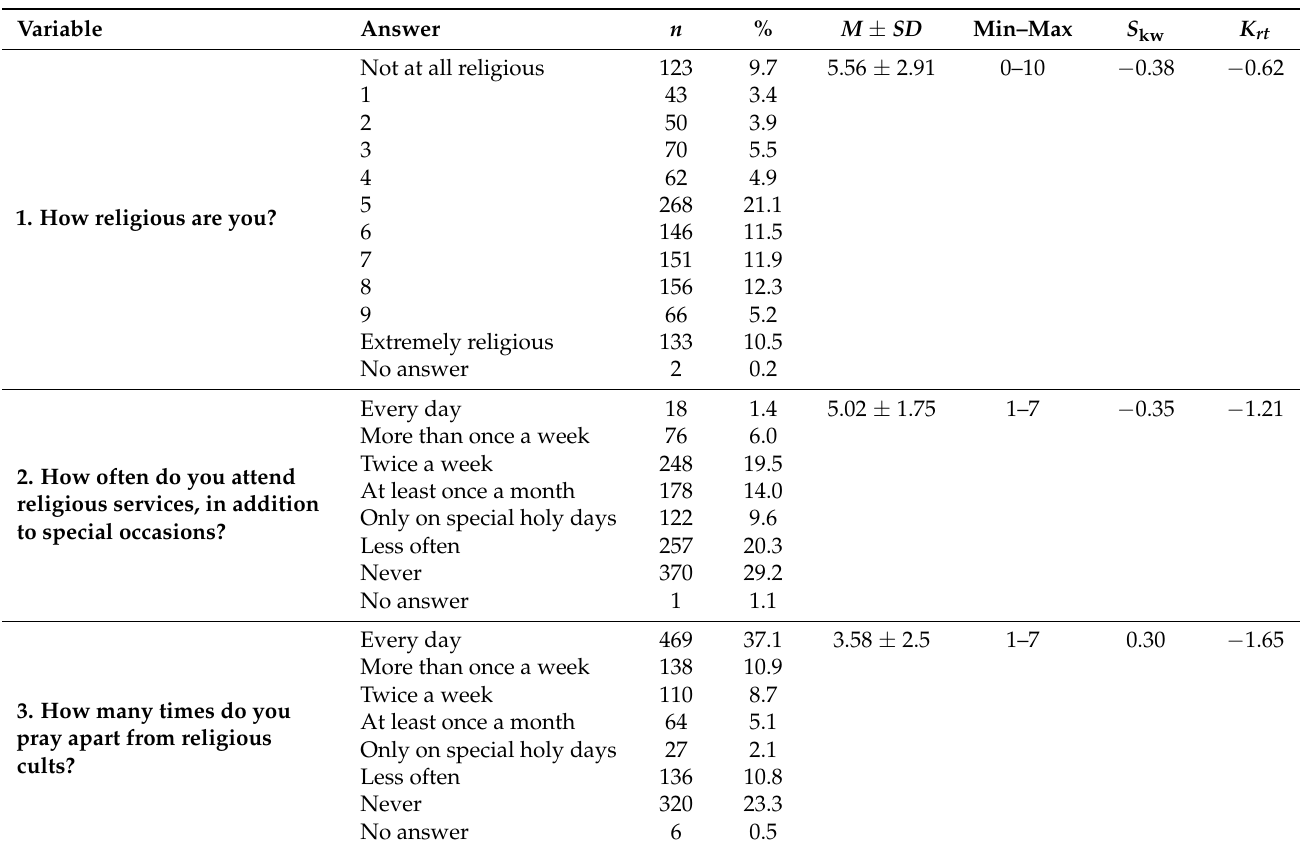
Table 2. Descriptive statistics of religion items ( N =